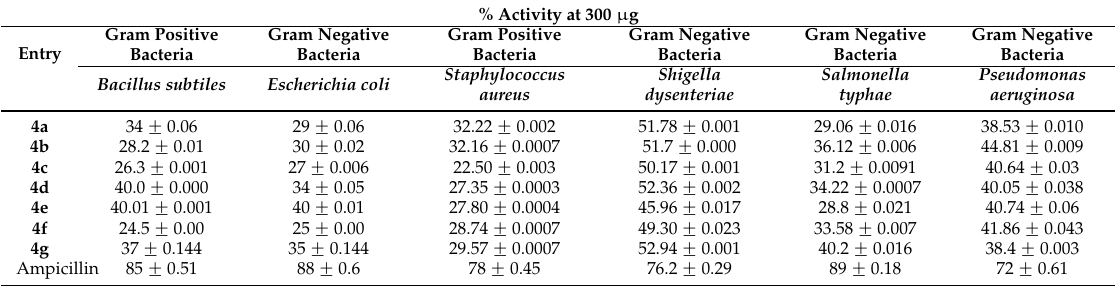
Table 8. Antibacterial activities (300 µ g) of 5-arylthiophene-2-sulfonylacetamide 4a – g . % Activity at 300 µ g